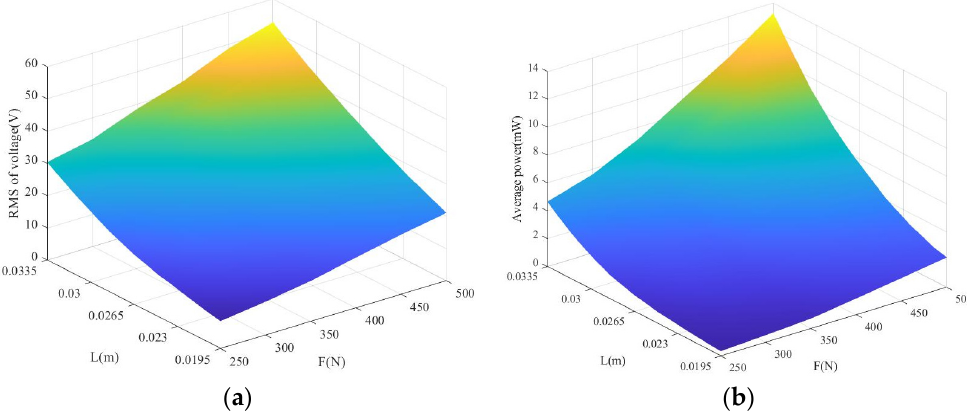
Figure 19. RMS of voltages and average powers from 1#1 PZT4 patch of 1# piezoelectric brick with Aluminum alloy substrate versus the force arm length of LPCB and the footstep excitation amplitude. ( a ) RMS of voltages; ( b ) Average powers.